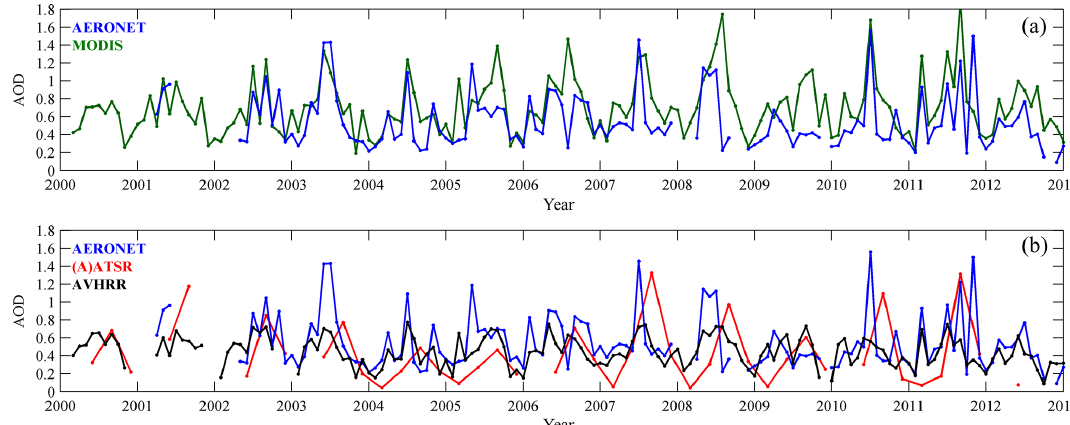
Figure 5. AOD time series for MODIS (a) and (A)ATSR and AVHRR (b) , with AERONET AOD (blue) as reference, over the XiangHe site for the years 2000–2012. For ATSR seasonally averaged AOD is plotted. For AVHRR and MODIS the AOD data are monthly averages.